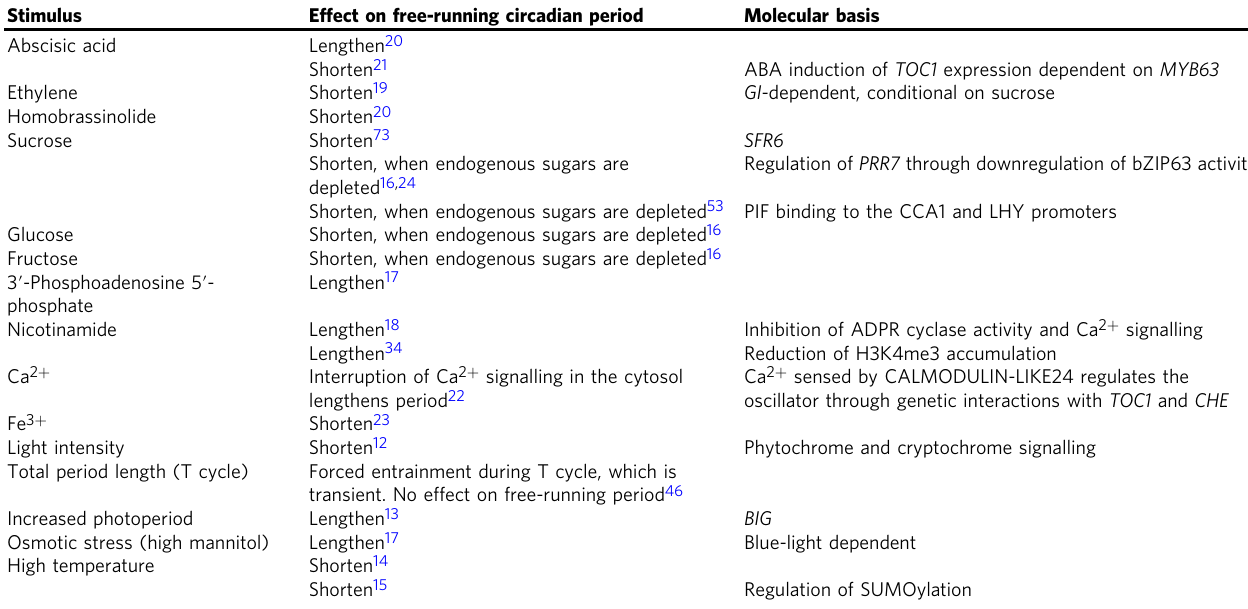
Table 1 Signals that adjust the free-running period of the circadian oscillator of Arabidopsis Stimulus